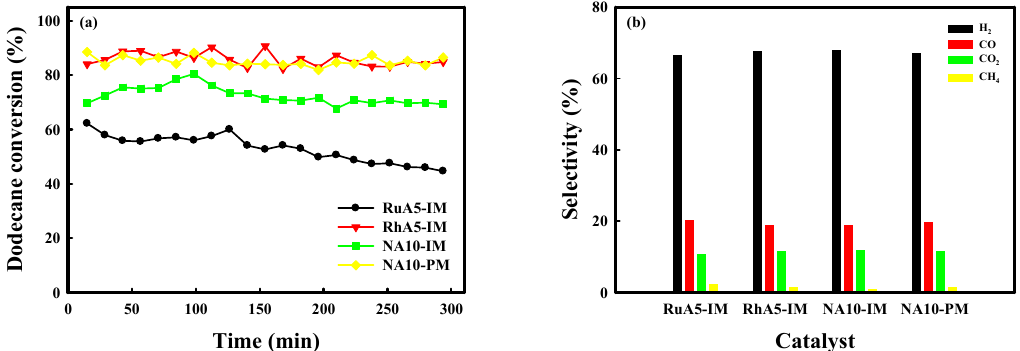
Figure 1. ( a ) Dodecane conversion and ( b ) initial selectivity of various auto-thermal catalysts under S/C = 1.23 and O 2 /C = 0.25 at 700 °C.